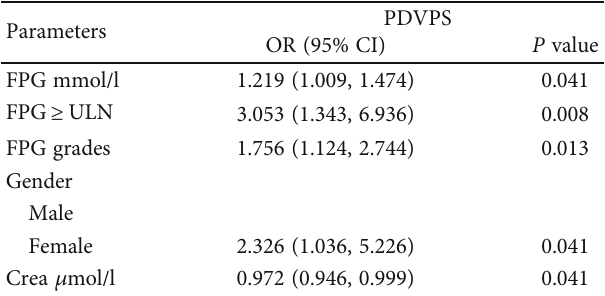
Table 4: Bivariate logistic regression of the association between clinical parameters and